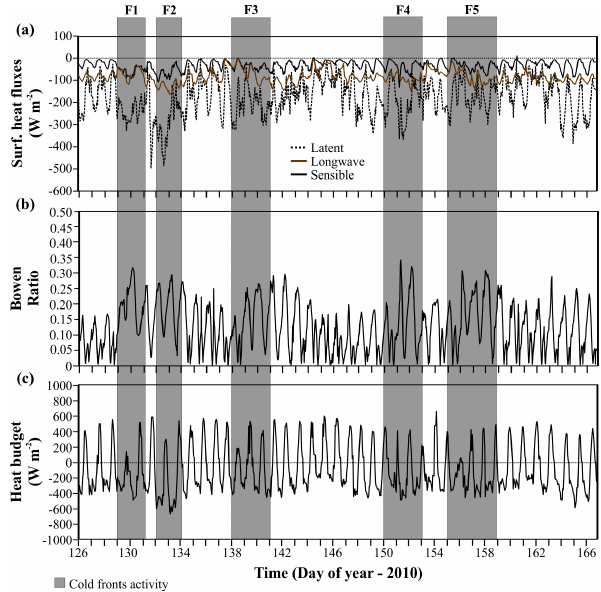
Figure 6. Time series of modeled surface heat flux components (a) , Bowen ratio (b) and total heat balance (c)